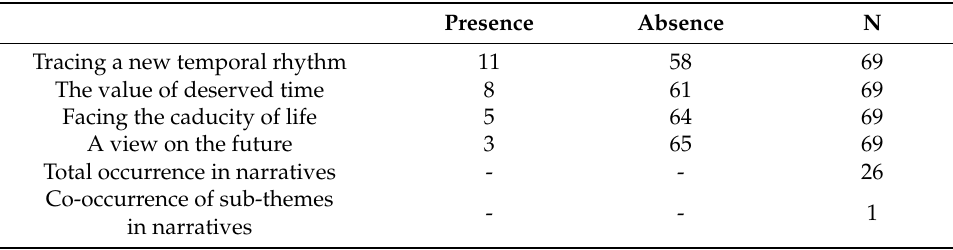
Table 2. Presence and absence in collected narratives of each sub-theme of the time dimension theme as they emerged from thematic analysis performed by researchers. Presence Absence N Tracing a new temporal rhythm 11 58 69 The value of deserved time 8 61 69 Facing the caducity of life 5 64 69 A view on the future 3 65 69 Total occurrence in narratives - - 26 Co-occurrence of sub-themes - in narratives